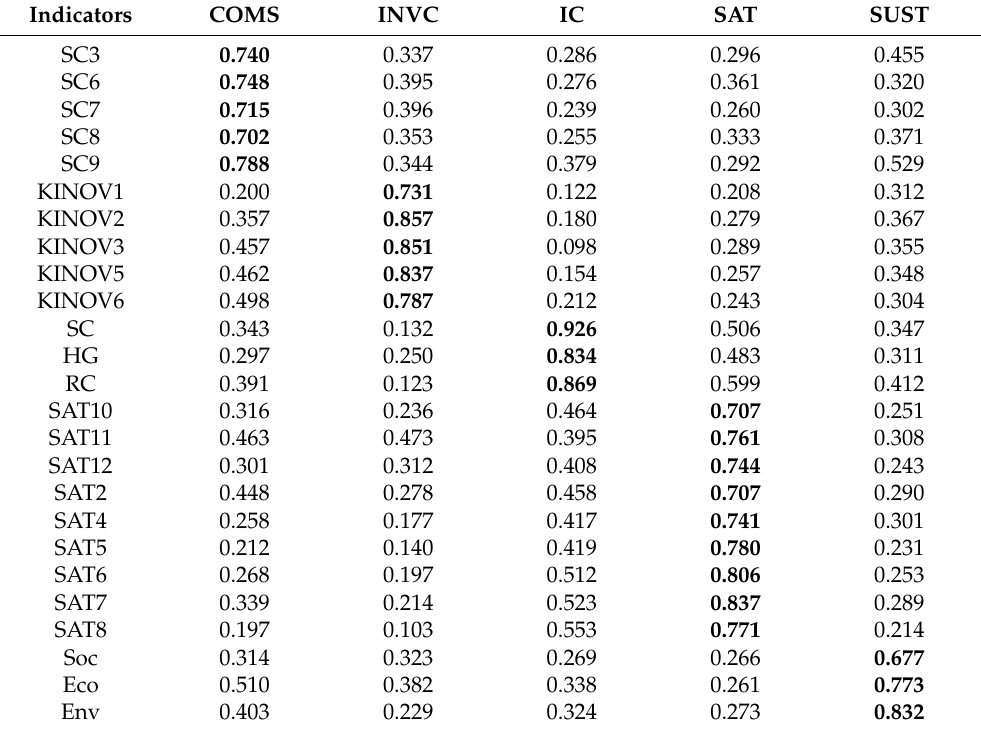
Table 4. Cross-loadings